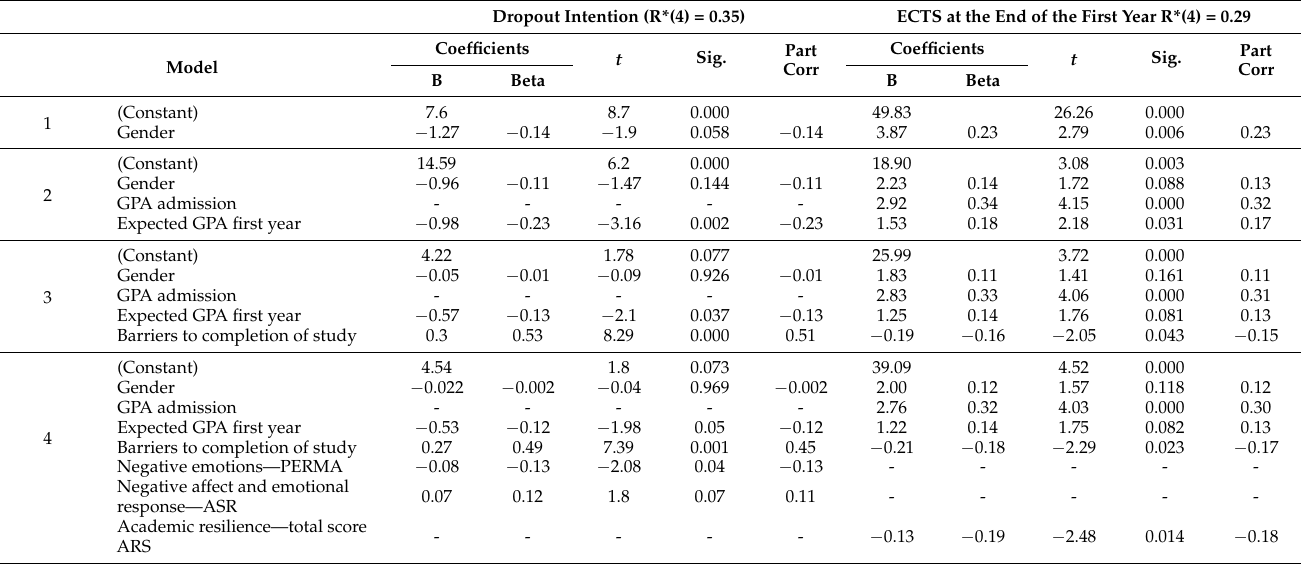
Table 9. Hierarchical regressions with dropout intention as dependent variable